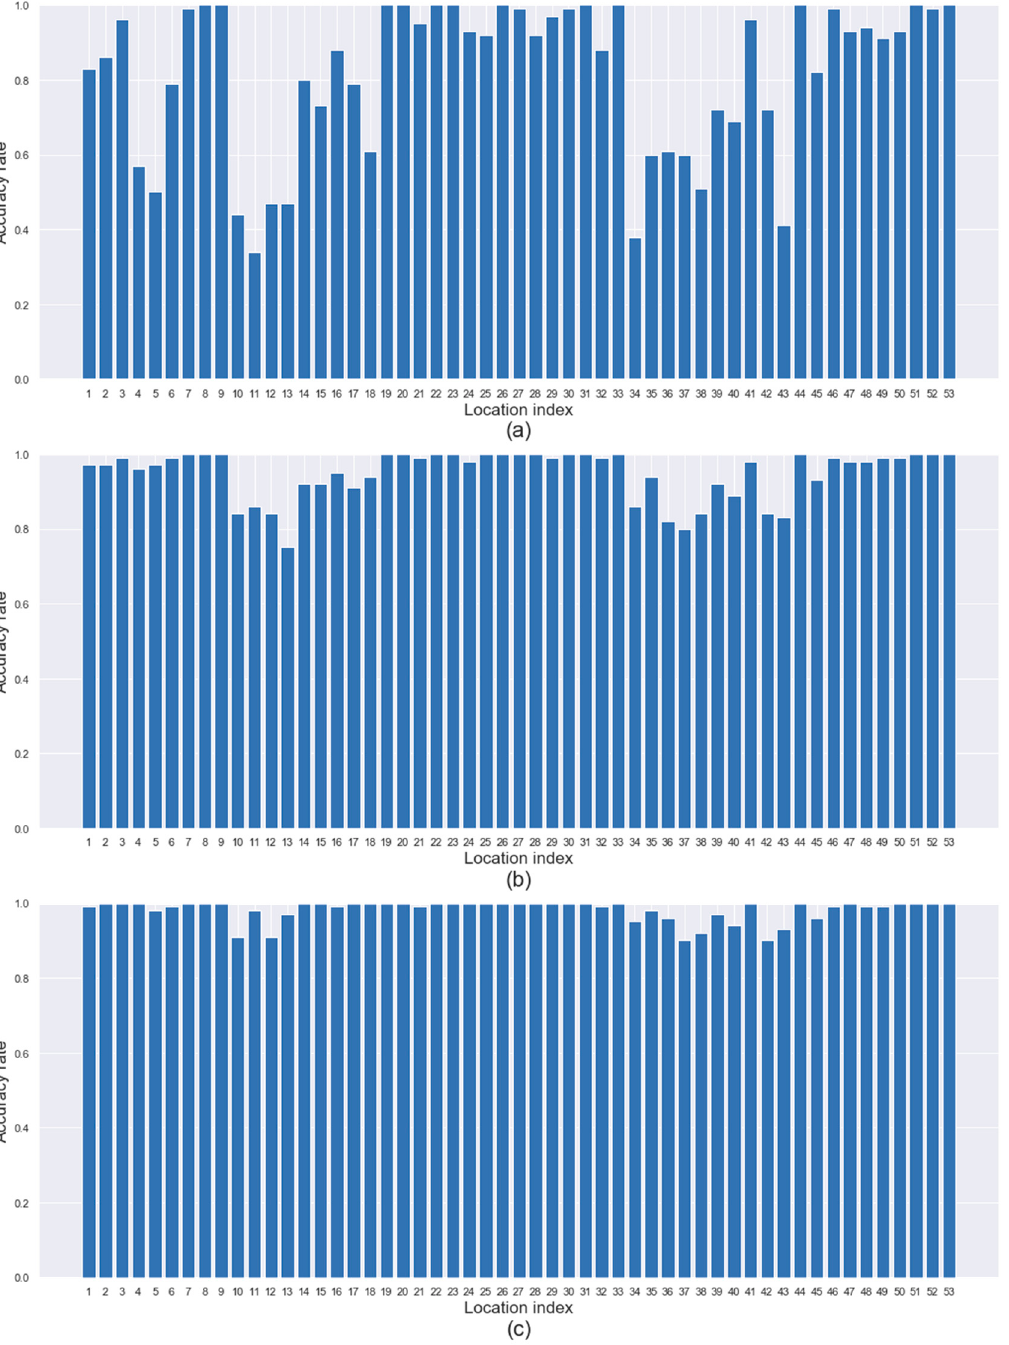
Figure 7. Identification accuracy regarding the top three locations under (L, L) configuration.